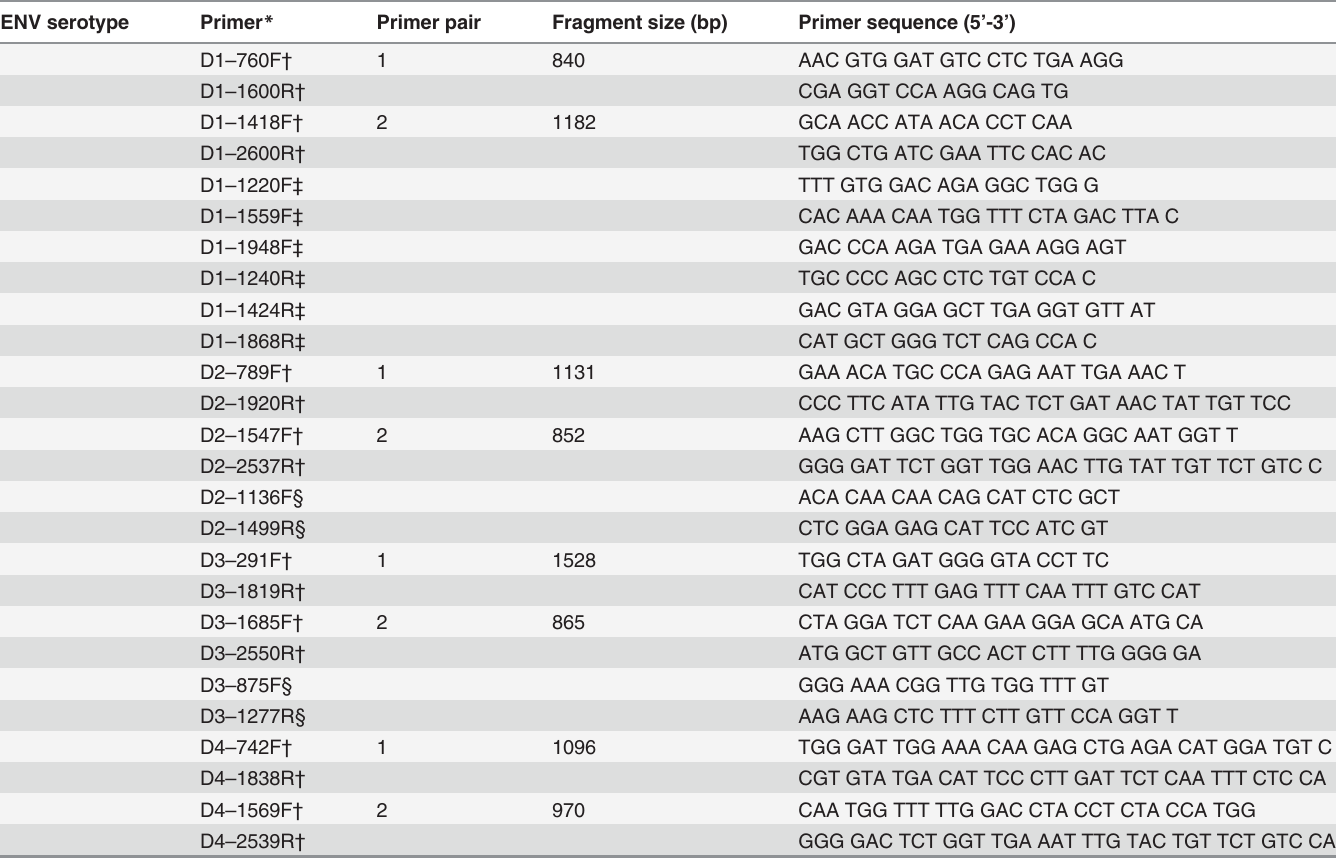
Table 2. Primers used in PCR ampli fi cation and sequencing reactions. DENV